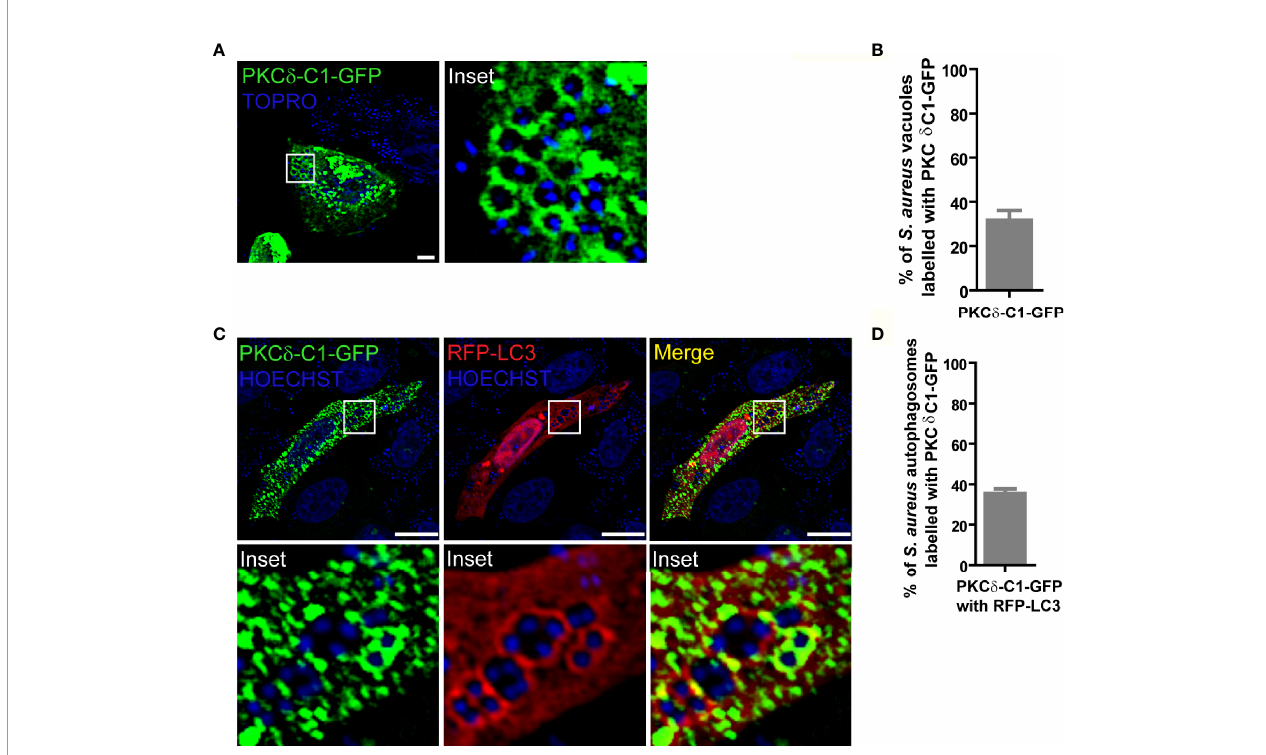
FIGURE 1 | DAG is present in the S. aureus phagosomal membranes. (A) Confocal microscopy images of CHO cells overexpressing PKC d -C1-GFP. Cells were infected with S. aureus wt for 4 hours as indicated under Material and Methods. Bacteria were labelled with Topro (shown in blue). Images are representative of three independent experiments. Bar: 10 m m. (B) Quanti fi cation of S. aureus vacuoles labelled with PKC d -C1-GFP. Data are the mean ± SEM of three independent experiments. (C) Confocal microscopy images of CHO cells overexpressing PKC d -C1-GFP together with RFP-LC3 and infected with S. aureus wt for 4 hours. Bacteria were labelled with Hoechst (shown in blue). Bar: 10 m m. Images are representative of three independent experiments. (D) Quanti fi cation of S. aureus vacuoles labelled with PKC d -C1-GFP and RFP-LC3. Data are the mean ± SEM of three independent